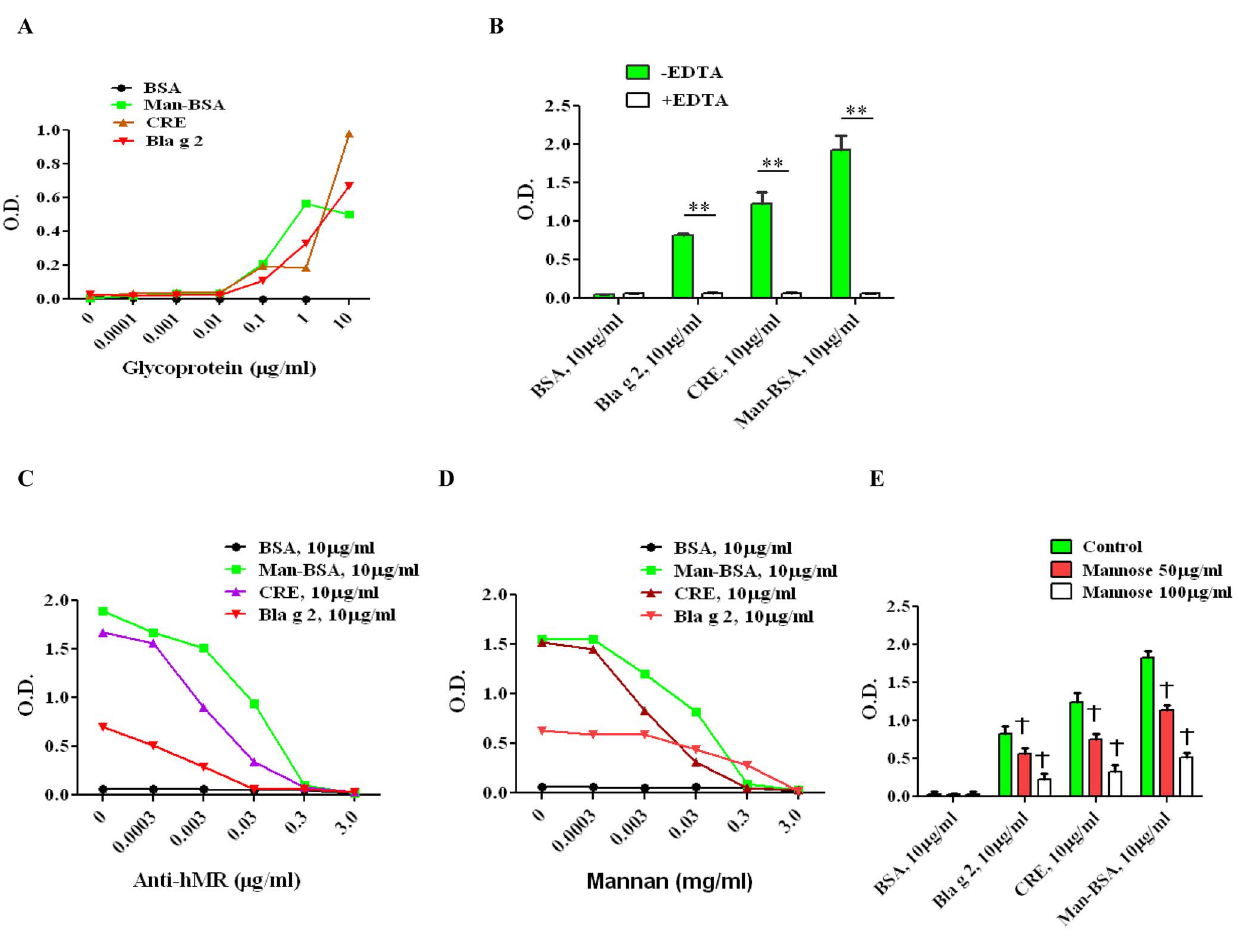
Figure 2. Binding assays of cockroach allergens and soluble CD206. ( A ) Serial dilution of 10 m g/ml of allergens including cockroach extract (CRE), purified Bla g 2, and positive (Man-BSA) and negative (BSA) controls were coated onto assay plates, and then probed with soluble CD206. ( B–E ) Inhibition assays were performed with or without 5 mM EDTA ( B ), and with serial dilution of anti-hMR ( C , 3.0 m g/ml), mannan ( D , 3 mg/ml), and mannose ( E , 100 m g/ml) added and incubated for 1 h before the allergens were added to the plates for binding. The relative binding activity was expressed as optical density (OD). Data are mean ODs of three individual experiments. ** P , 0.01 ( B ), { P , 0.01 ( E , compared to medium control).